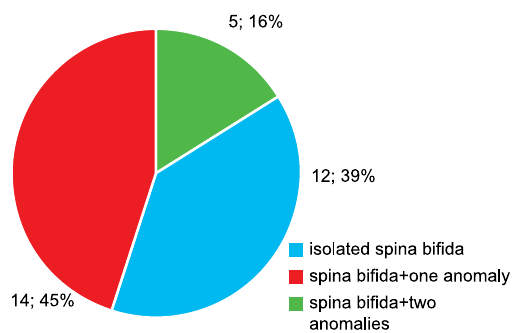
FIGURe 3. Frequency of spina bifida with associated anoma - lies